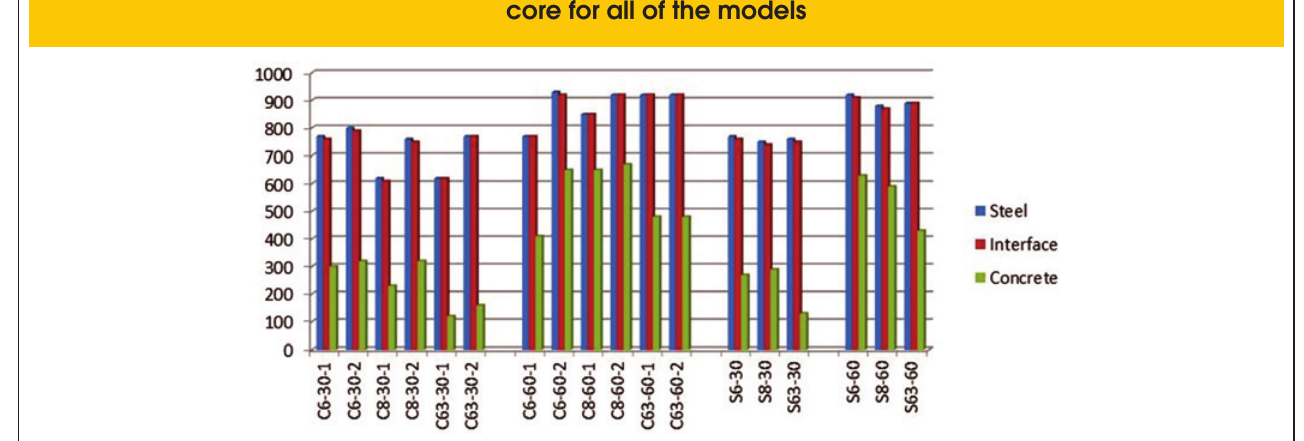
Figure 20 – Temperatures achieved in the steel, at the interface and in the concrete core for all of the